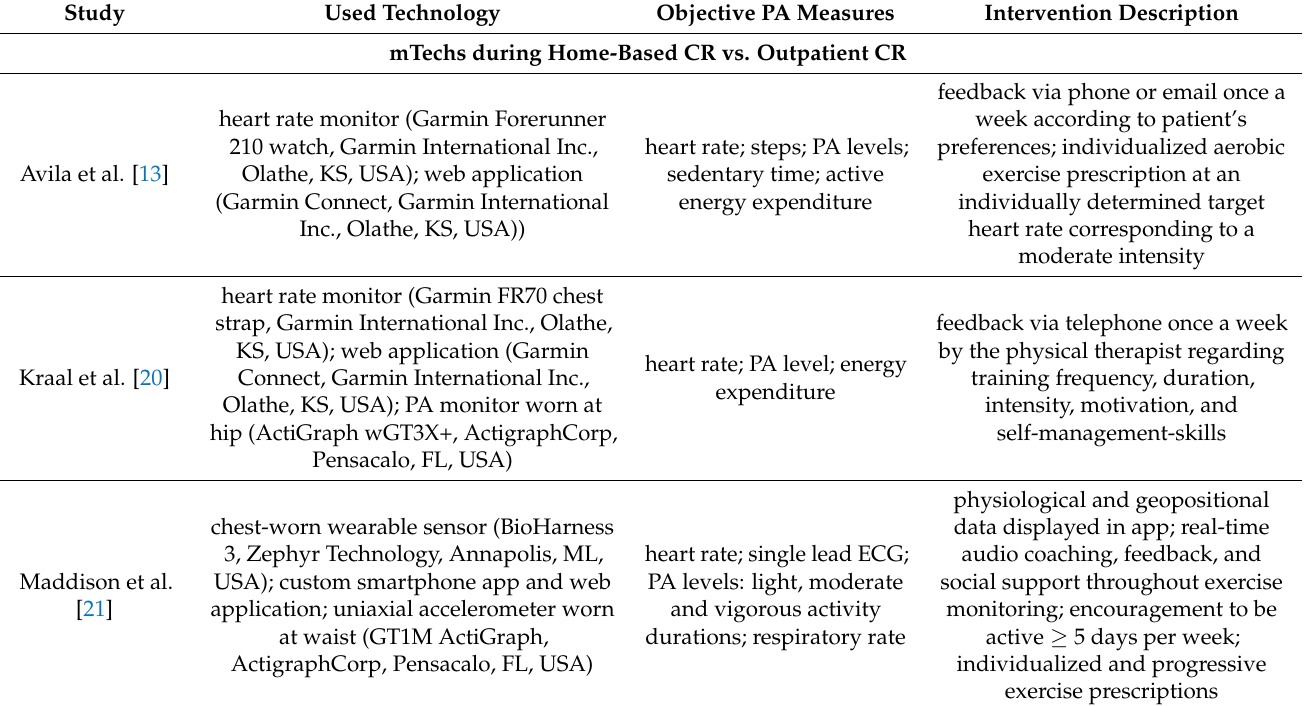
Table 3. Technologies, measures of physical activity (PA) and intervention description.